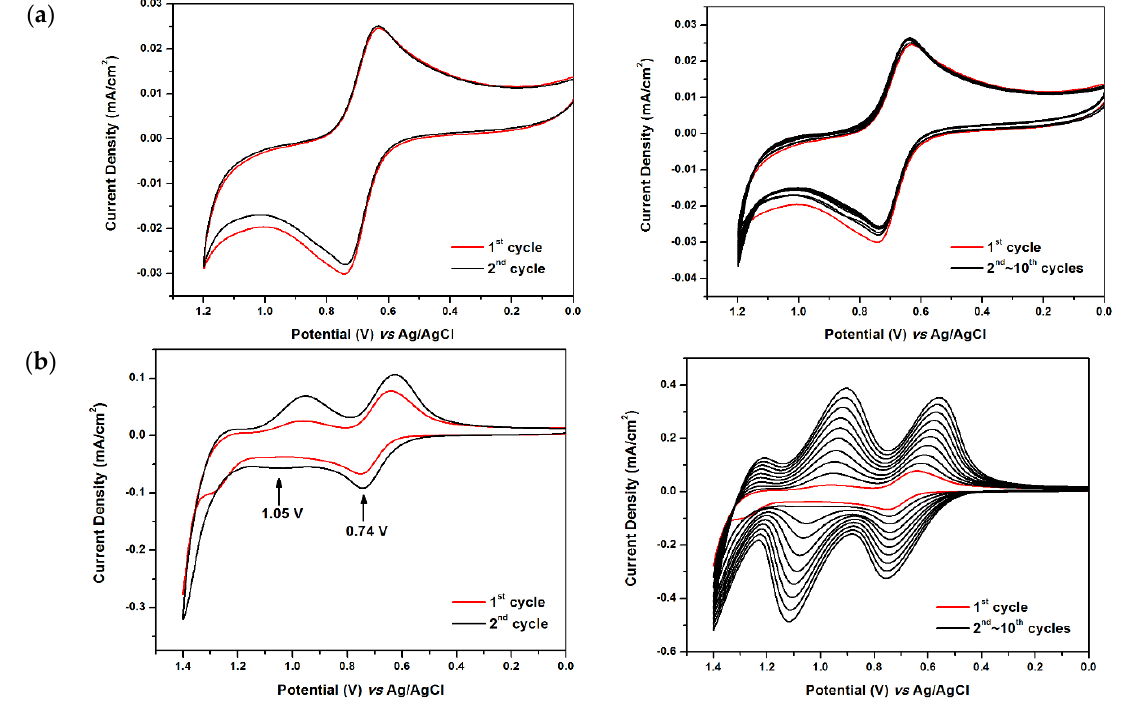
Figure 6. Repetitive cyclic voltammograms of 2 × 10 − 4 M MeOTPA-(NPC) 2 in 0.1 M Bu 4 NClO 4 /CH 2 Cl 2 solution in the potential range of ( a ) 0–1.2 V and ( b ) 0–1.4 V at a scan rate of 50 mV · s − 1 .